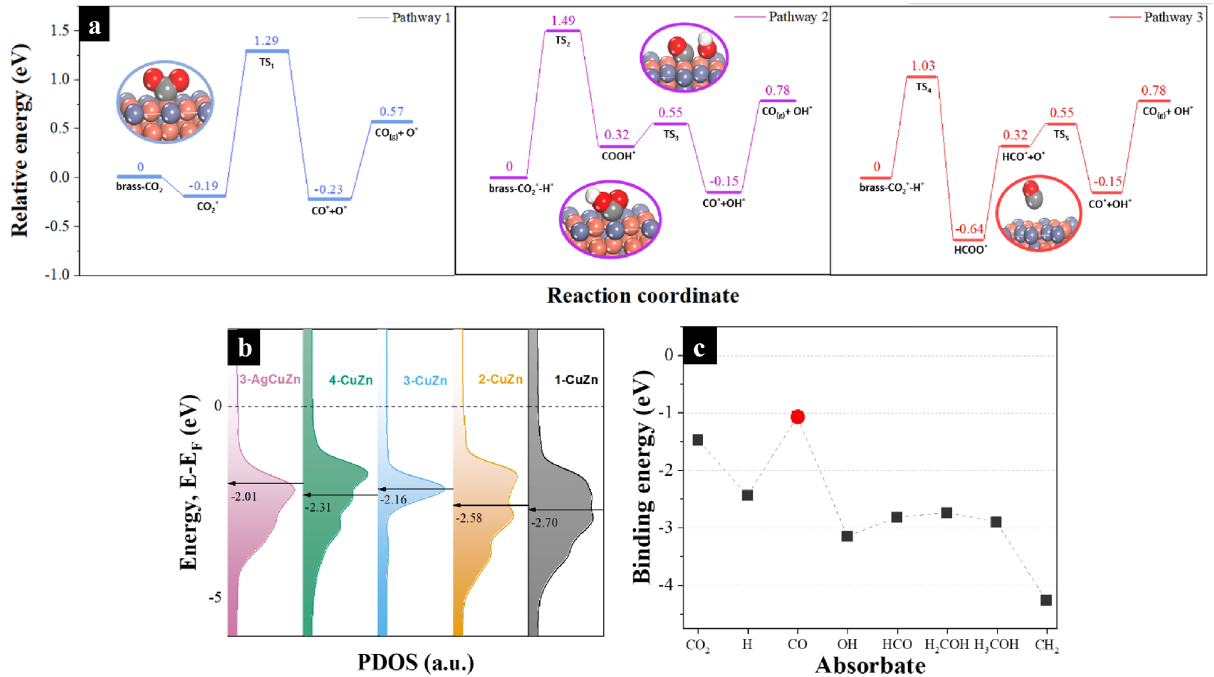
Figure 5. ( a ) Potential energy profile of the mechanism for the three proposed pathways for CO formation on sample 3-CuZn: direct dissociation, H-assisted via COOH*, and via HCOO*. ( b ) The projected density of states (PDOS) of the Cu atom in the four samples on the (111) plane and the d-band center represented by the black arrow while the Fermi level is the dotted line, and ( c ) the binding energy of the different adsorbates